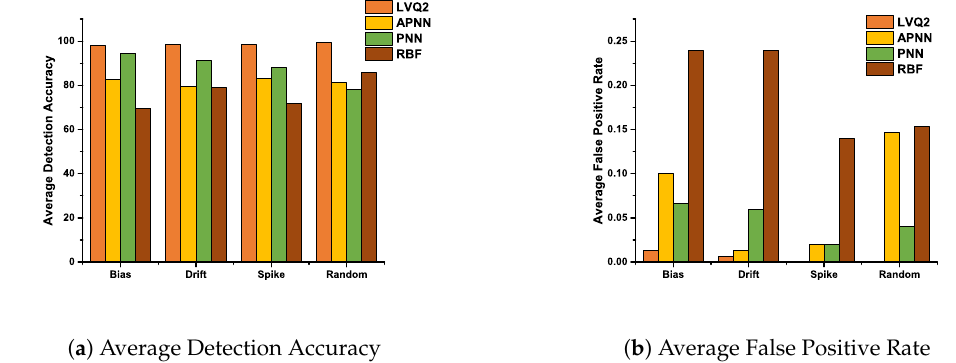
Figure 10. Average detection accuracy and average false positive rate of various NNs for all faults. Table 1. Detection performance of various classification techniques.